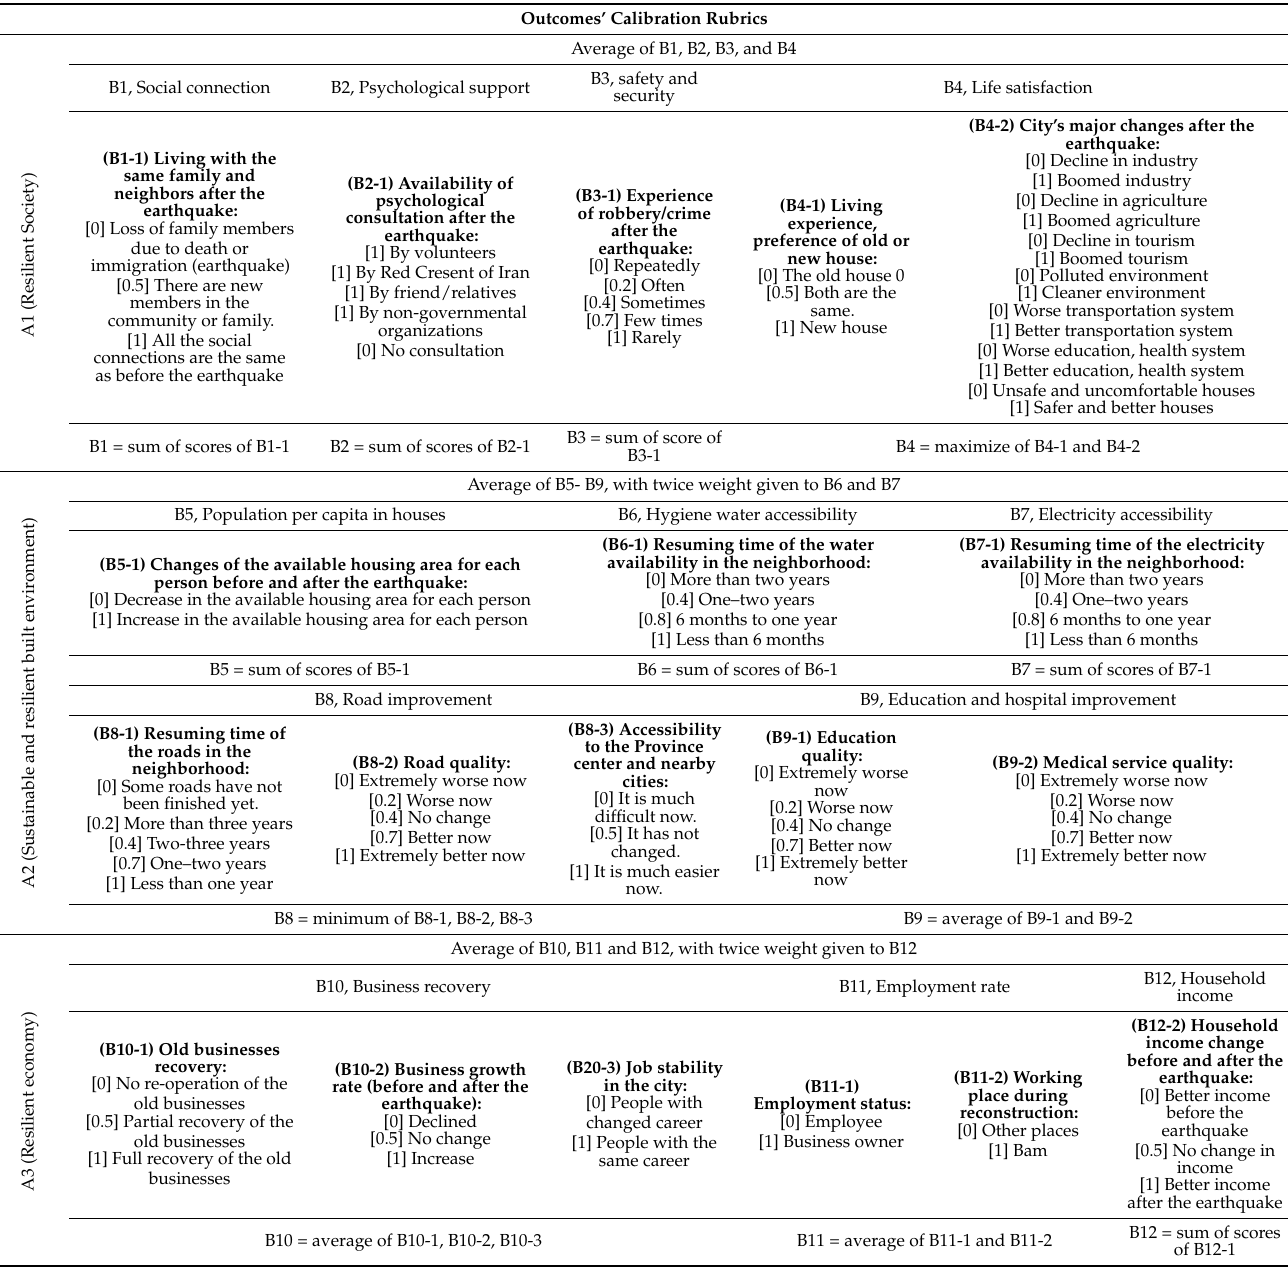
Table A2. Outcomes’ calibration rubrics. Outcomes’ Calibration